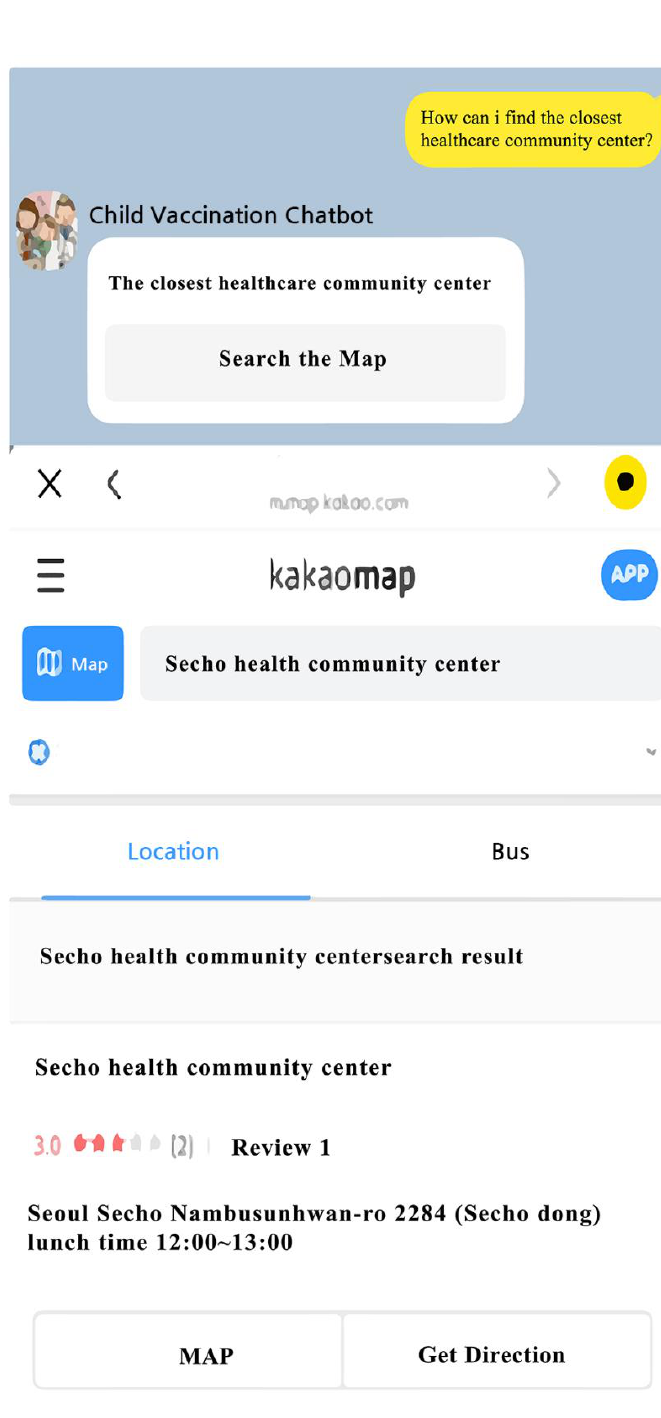
Figure 3. Searching for a public health center.